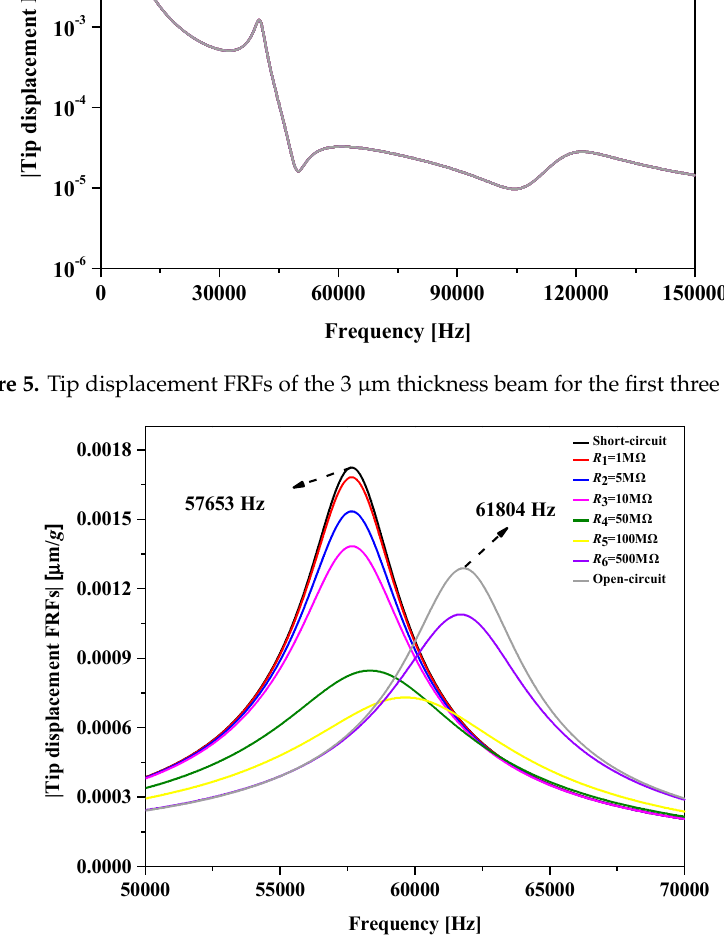
Figure 6. Tip displacement FRFs of the 0.3 µ m thickness beam with the tip mass M t for the first mode.